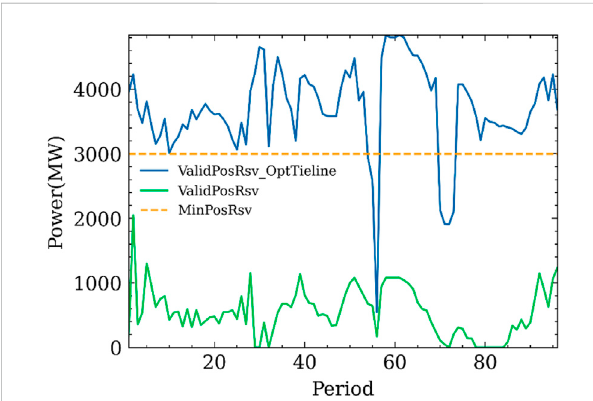
FIGURE 6 Comparison diagram of the effective positive reserve before and after optimizing the power of the tie-line.